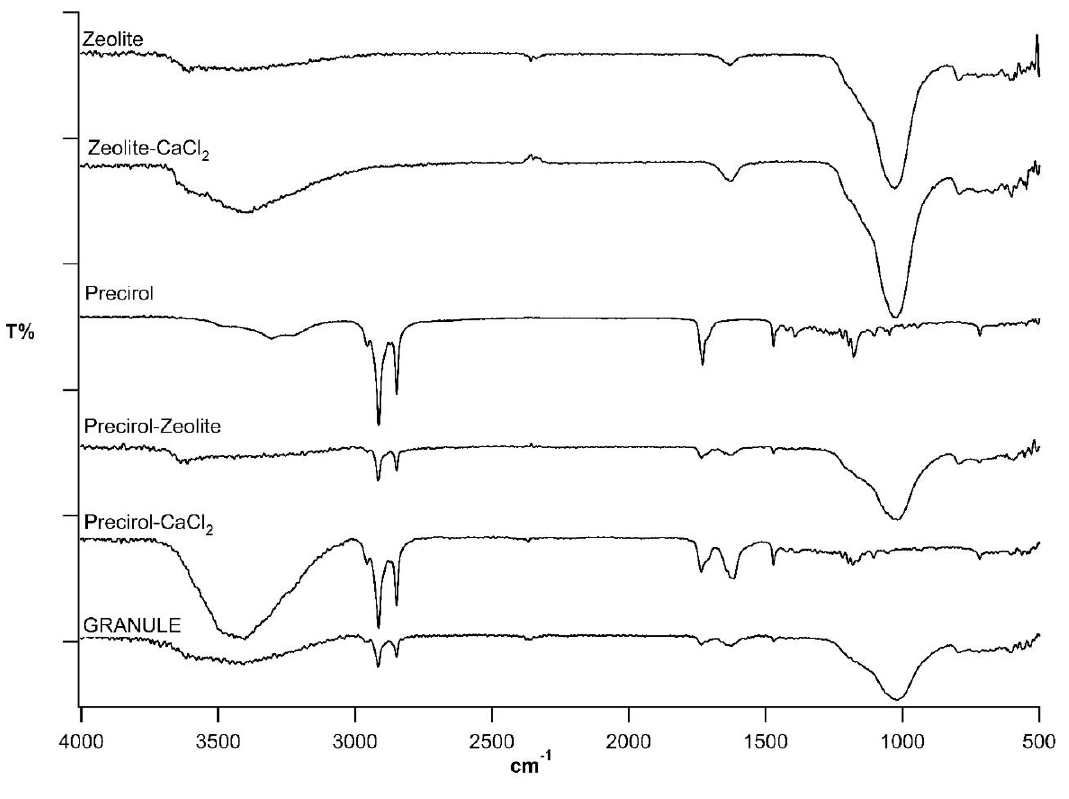
Figure 3. Attenuated Total Reflectance-Fourier Transform InfraRed (ATR-FTIR) spectra of Z:P (80:20) 1.2 (GRANULE) and formulation components. Table 2. Bands H–O–H of hydration associated water. Signals for the: stretching (symmetrical, v s and asymmetrical, v as ) of Si–O and C–H bonds; bending (symmetrical, δ s and asymmetrical, δ as ) of C–H bond; stretching of ester carbonyl.